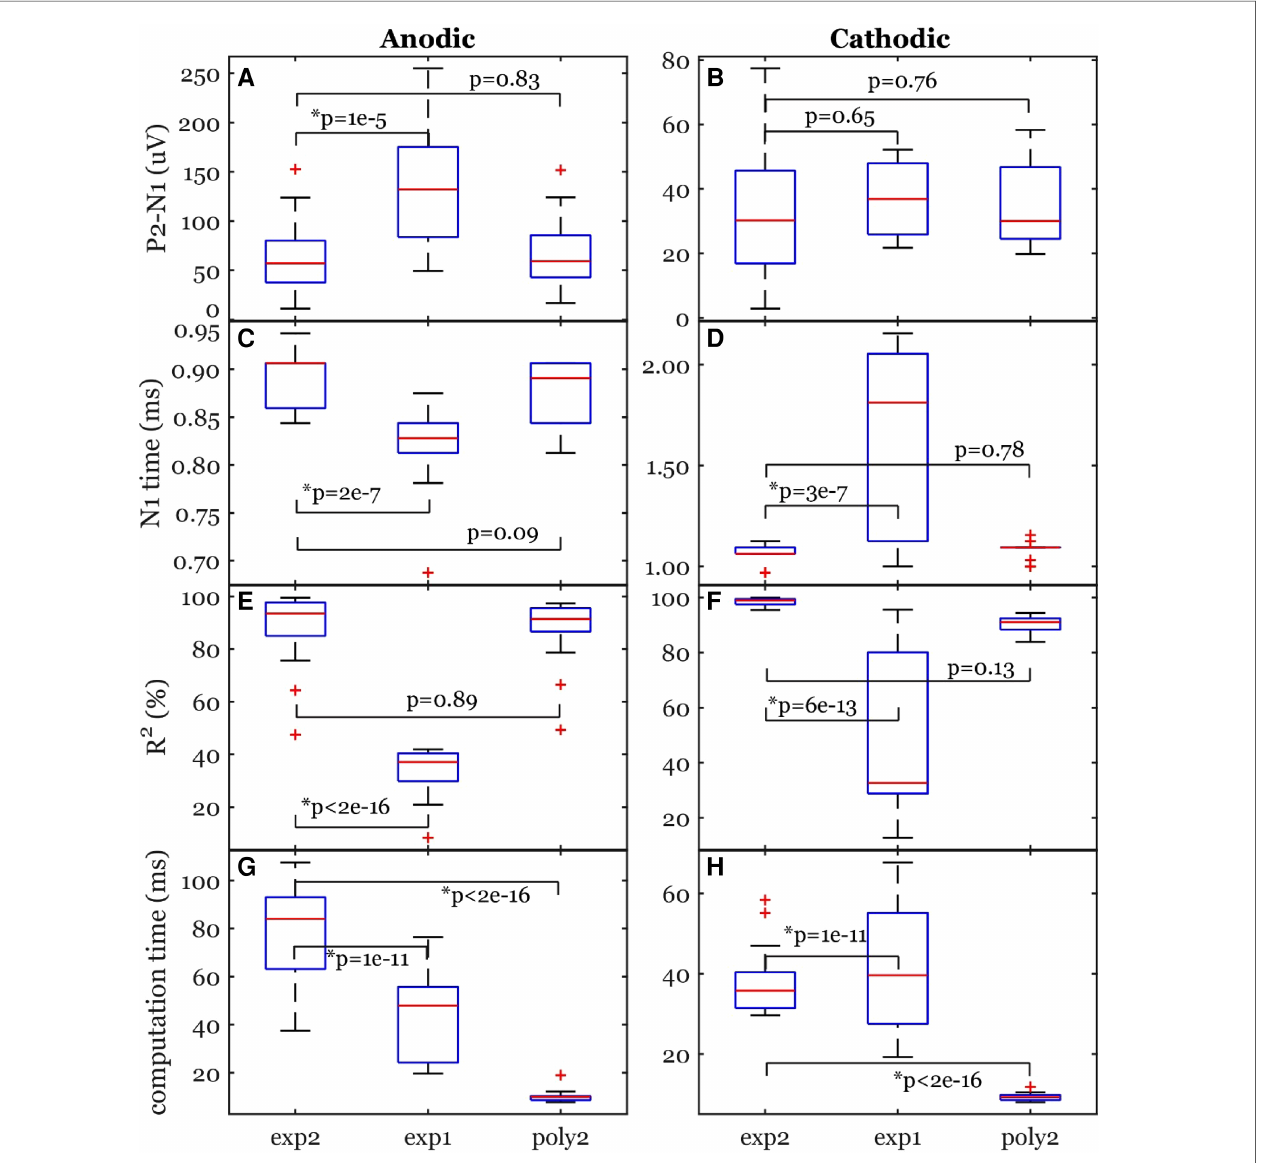
FIGURE 5 Common ECAP characteristics: ( A,B ) peak-valley amplitude (P2-N1) and ( C,D ) N1 time; ( E,F ) the goodness of fi t across three curve fi ttings; ( G,H ) the computation time for a fi t. exp2: double exponential, exp1: single exponential, poly2: 2nd order polynomial. The p -values come from linear models. The data included 20 observations from two participants with stimulation amplitudes suf fi cient to evoke ECAP in each